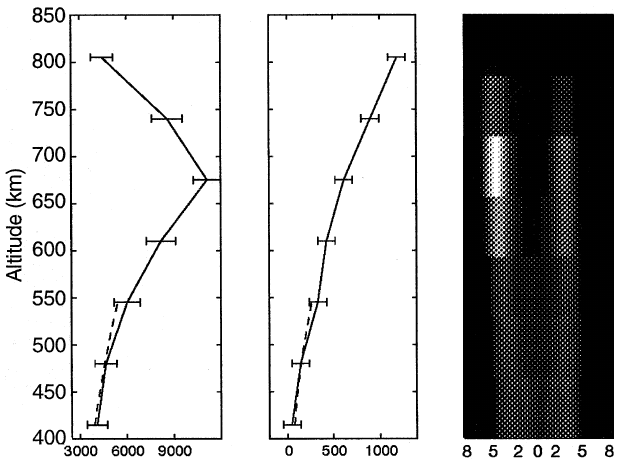
Fig. 5. Same as Fig. 3 at 1335:00 UT